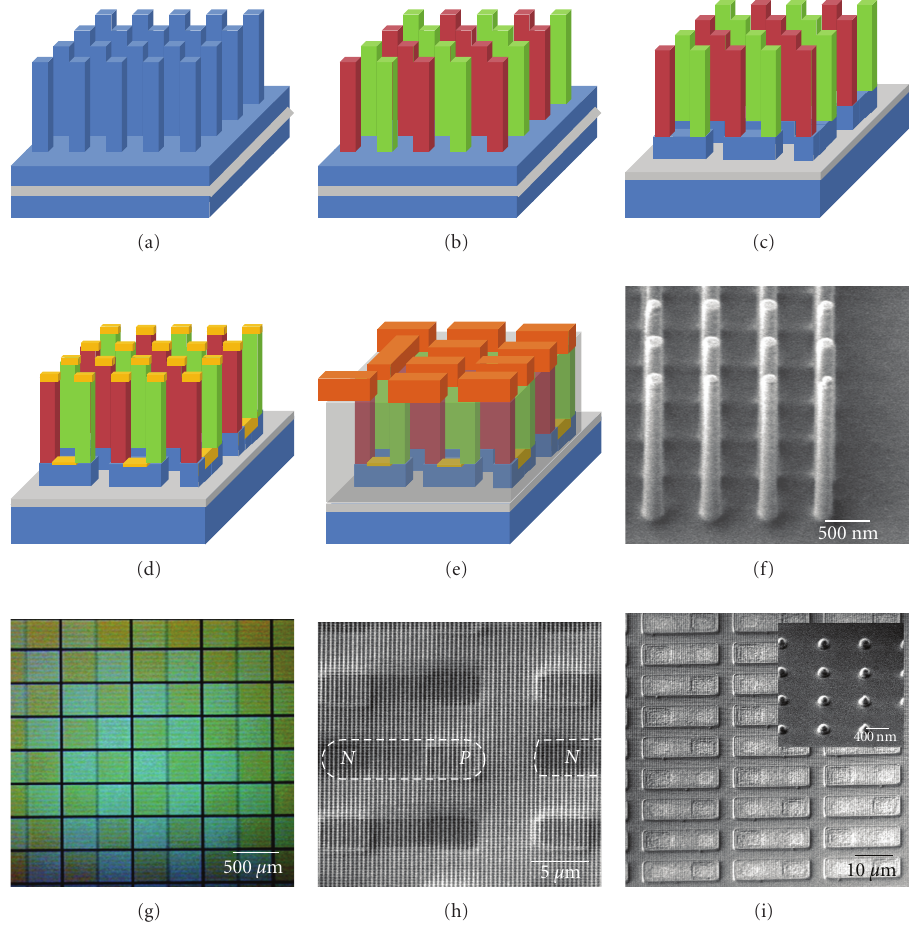
Figure 23: Schematic of fabrication (a) SiNW formation by dry etch, (b) Ion implantation, P/N elements definition, each element consists of hundreds of SiNW, (c) P/N couples formed by dry etch, (d) SiNW top and bottom silicidation while protecting the sidewall, (e) dielectric deposition and etch back to expose only the tip of the SiNW, and Top metallization. (f) SEM images of pillar formation, (g) N & P implants can be seen clearly under microscope with a di ff erent shade, (h) SEM image of SiNW after N/P implant, and (i) metallization etch showing individual N/P couples. Inset shows the tips of the SiNW exposing after oxide etch which confirms structure of the TEG. (h) and (i) are images of test structures, the actual design is too large to be shown in SEM image. (Reprinted with permission from [70]. [2011]